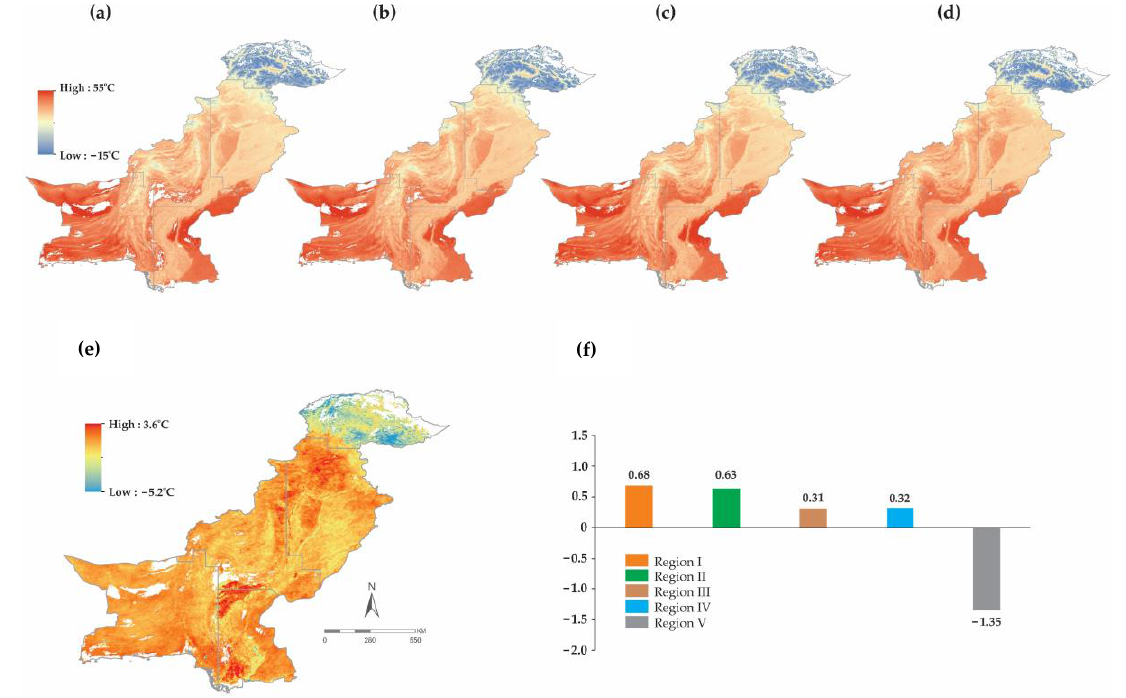
Figure 6. Spatial distribution of annual mean LST in Pakistan. ( a – d ) Mean LSTs of 2018, 2019, 2020, and 2021. ( e ) LST difference between 2018 and 2021 on spatial scales. ( f ) Bar chart for mean LST difference for sub-regions of Pakistan.